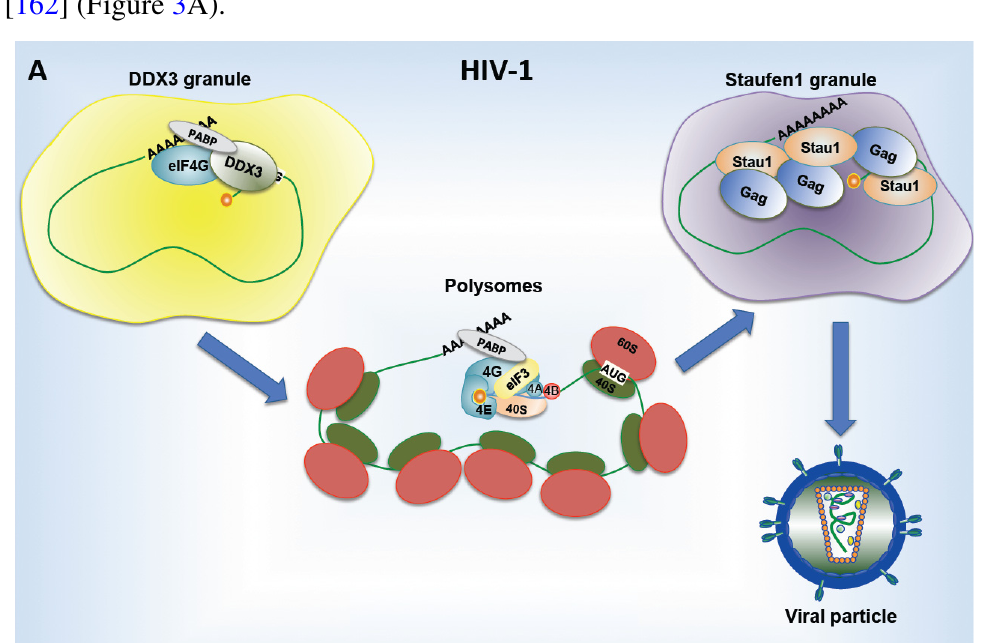
Figure 3. Cont Figure 3. Cont.